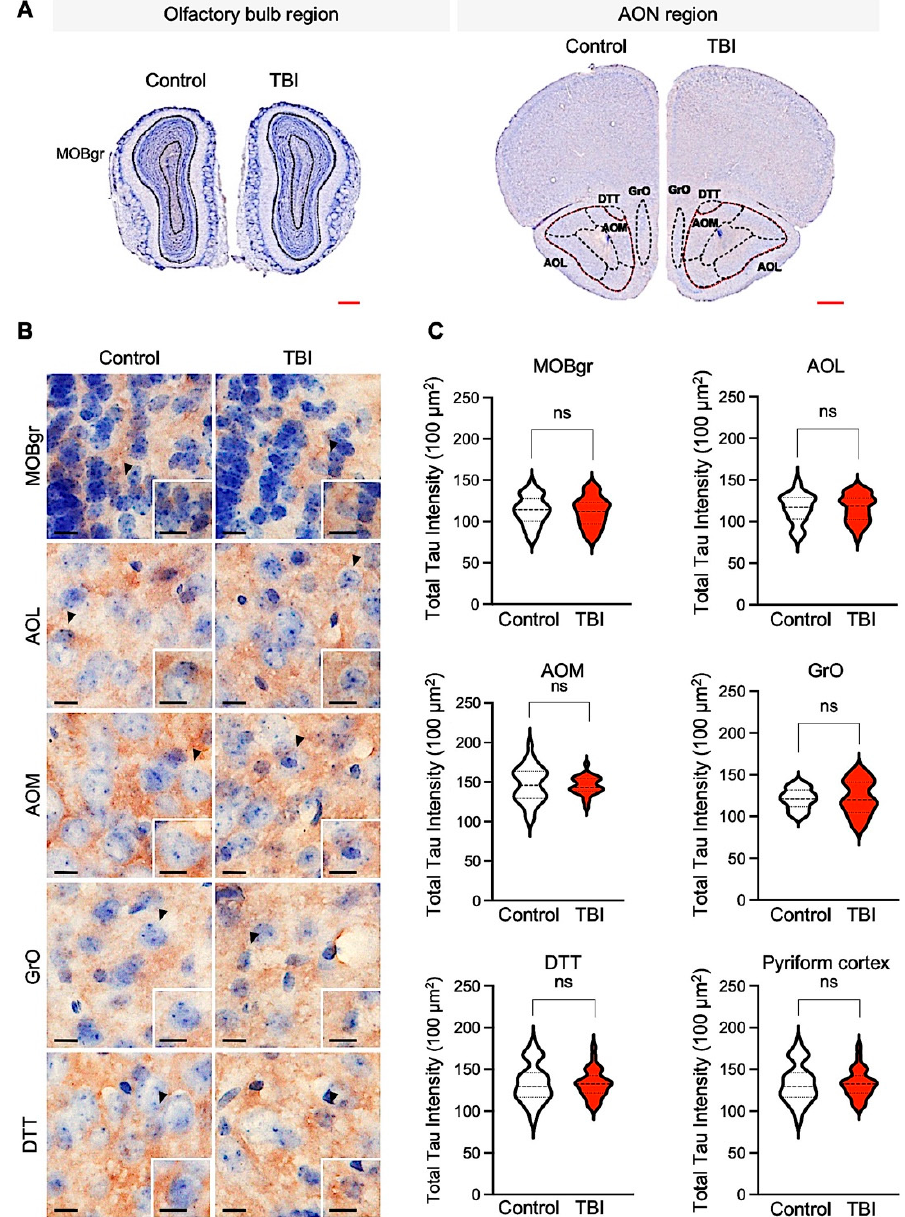
Figure 4. Olfactory ‐ bulb ‐ associated areas exhibit no difference of total tau level in TBI mice. ( A ) Representative hemisphere images of the olfactory bulb region (coronal section) in control and TBI mice ( upper panel ). Scale bars (red): 500 μ m. ( B ) High ‐ magnification images of the olfactory bulb region in control and TBI mice. Scale bars (black): 10 μ m ( C ) Densitometry analysis showed no difference in total tau level in repetitive TBI mice compared to control mice (control, N = 5; repetitive TBI, N = 5). Error bars indicate SEM; ns, not significant.